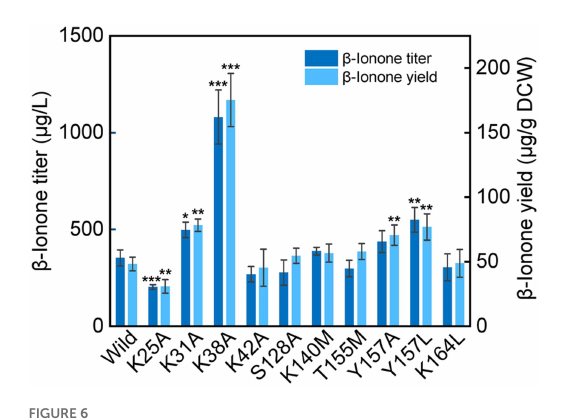
FIGURE 6 β -Ionone production in the wild-type strain of NtCCD1-3 (Wild) and the mutants. Error bars represent the standard deviation of three biological replicates. p values were determined by one-way ANOVA (* p < 0.05; ** p < 0.01; *** p <